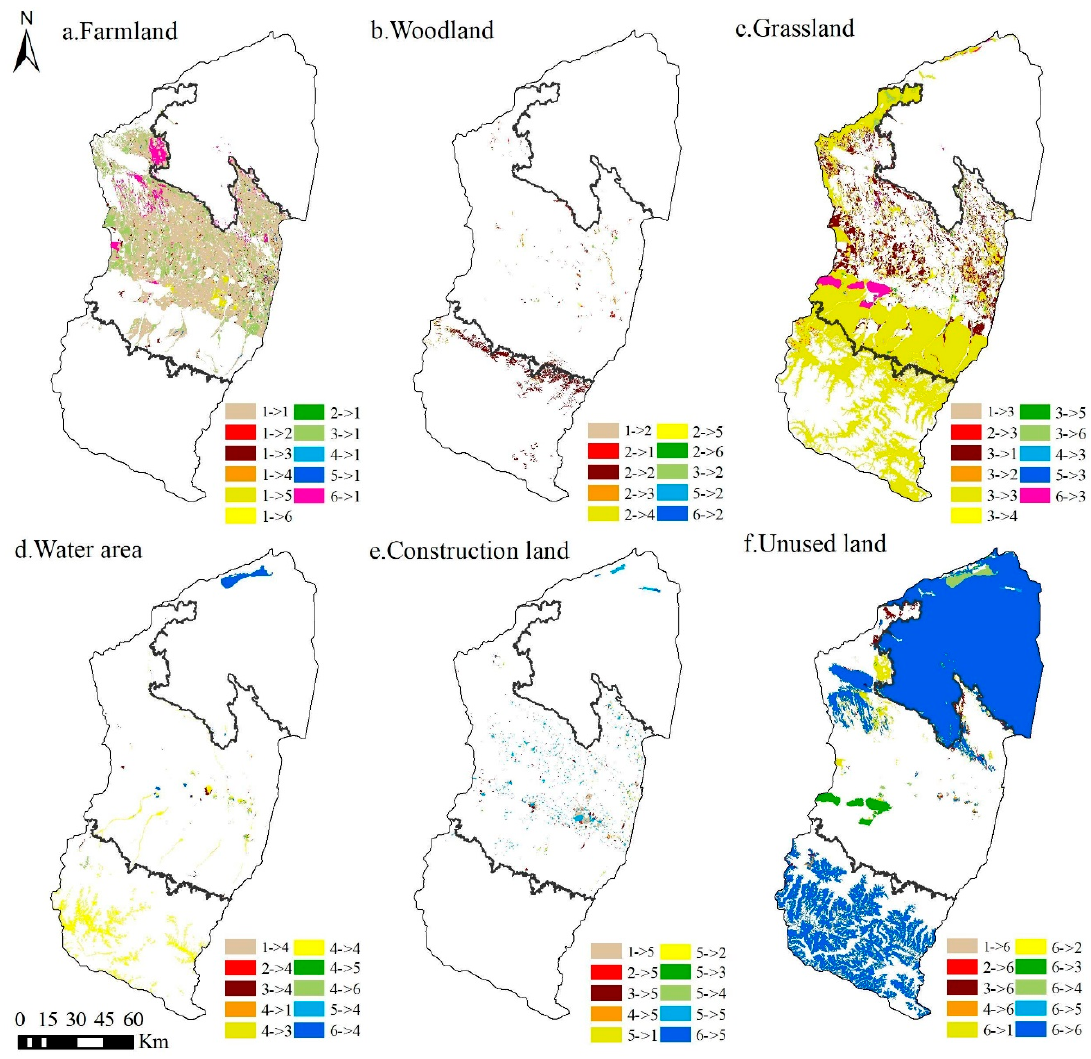
Figure 11. Spatial changes in LULC in the Manas River Basin from 1980 to 2020. (1, Farmland; 2, Woodland; 3, Grassland; 4, Water area; 5, Construction land; 6, Unused land).